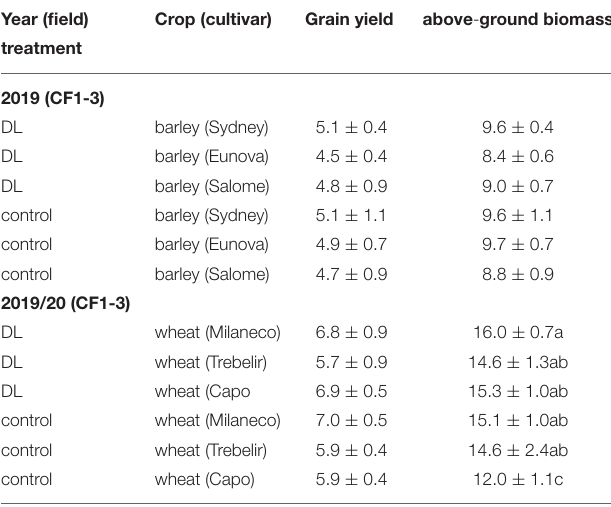
TABLE 3 | Observed (obs, mean ± standard deviation) spring barley and winter wheat dry matter grain yield and AGB, both in t ha − 1 , in 2019 for three cultivars of the treatment with strip-wise subsoil loosening (DL) at the melioration strip and the control treatment